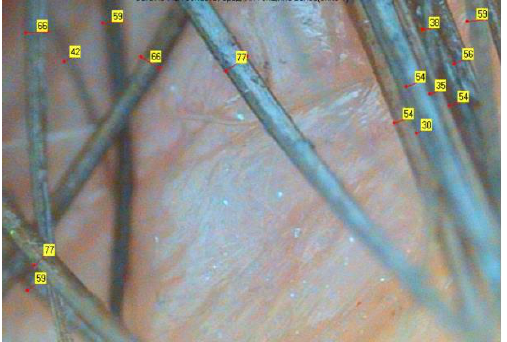
Figure 2. The determination of a single hair diameter was conducted under ×200 magnification lenses. The numbers in yellow squares ind icate the hair diameter in μm. The follicle state (diameter in μm) and hair shaft (fat and water presence) conditions were quantified as well (Figure 3).